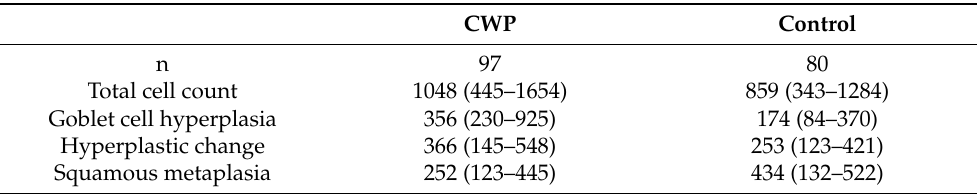
Table 2. Absolute numbers from bronchoscopy exfoliative cytology of coal workers’ pneumoconiosis (n = 97) and controls (n = 80).